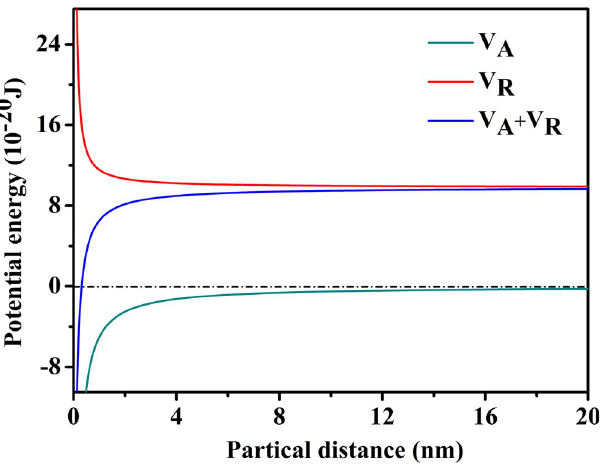
Fig 5. Interaction energy curves between HPG colloidal